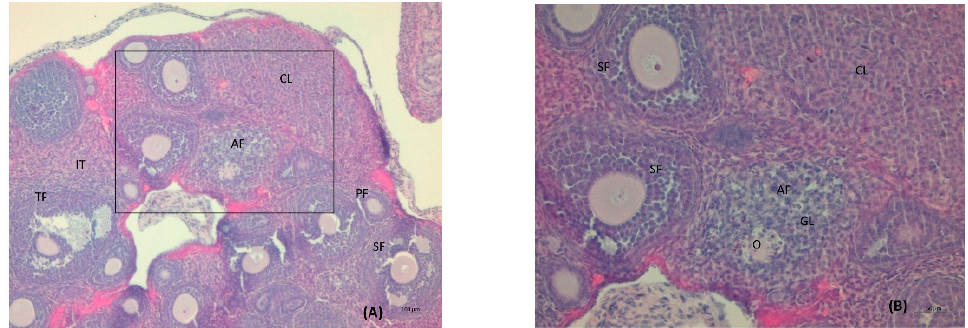
Figure 4. Histological sections of the ovaries of intact mice: tertiary follicle. O: oocyte; GL: granulosa layer; A: antrium; LPF: late primary follicle; PrF: primodial follicle; IT: interstitial tissue; TF: theca folliculi; TE: theca externa; TI: theca interna (H&E; power 100×( A )/400×( B )).